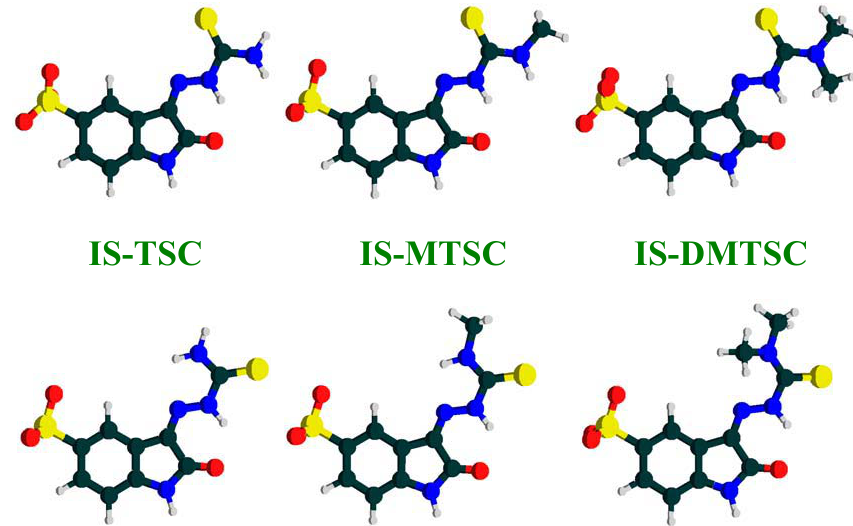
Fig. 4 Optimized structures of isatin-5-sulfonate-based